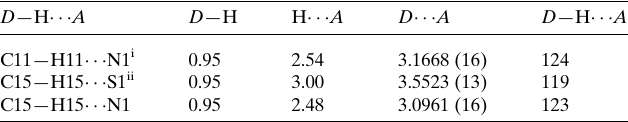
Symmetry codes: (i) (cid:3) x þ 1 ; (cid:3) y þ 1 ; (cid:3) z þ 1; (ii) (cid:3) x þ 1 ; y ; (cid:3) z þ 3 2 . Table 4 Hydrogen-bond geometry (A˚ , (cid:2) ) for 2